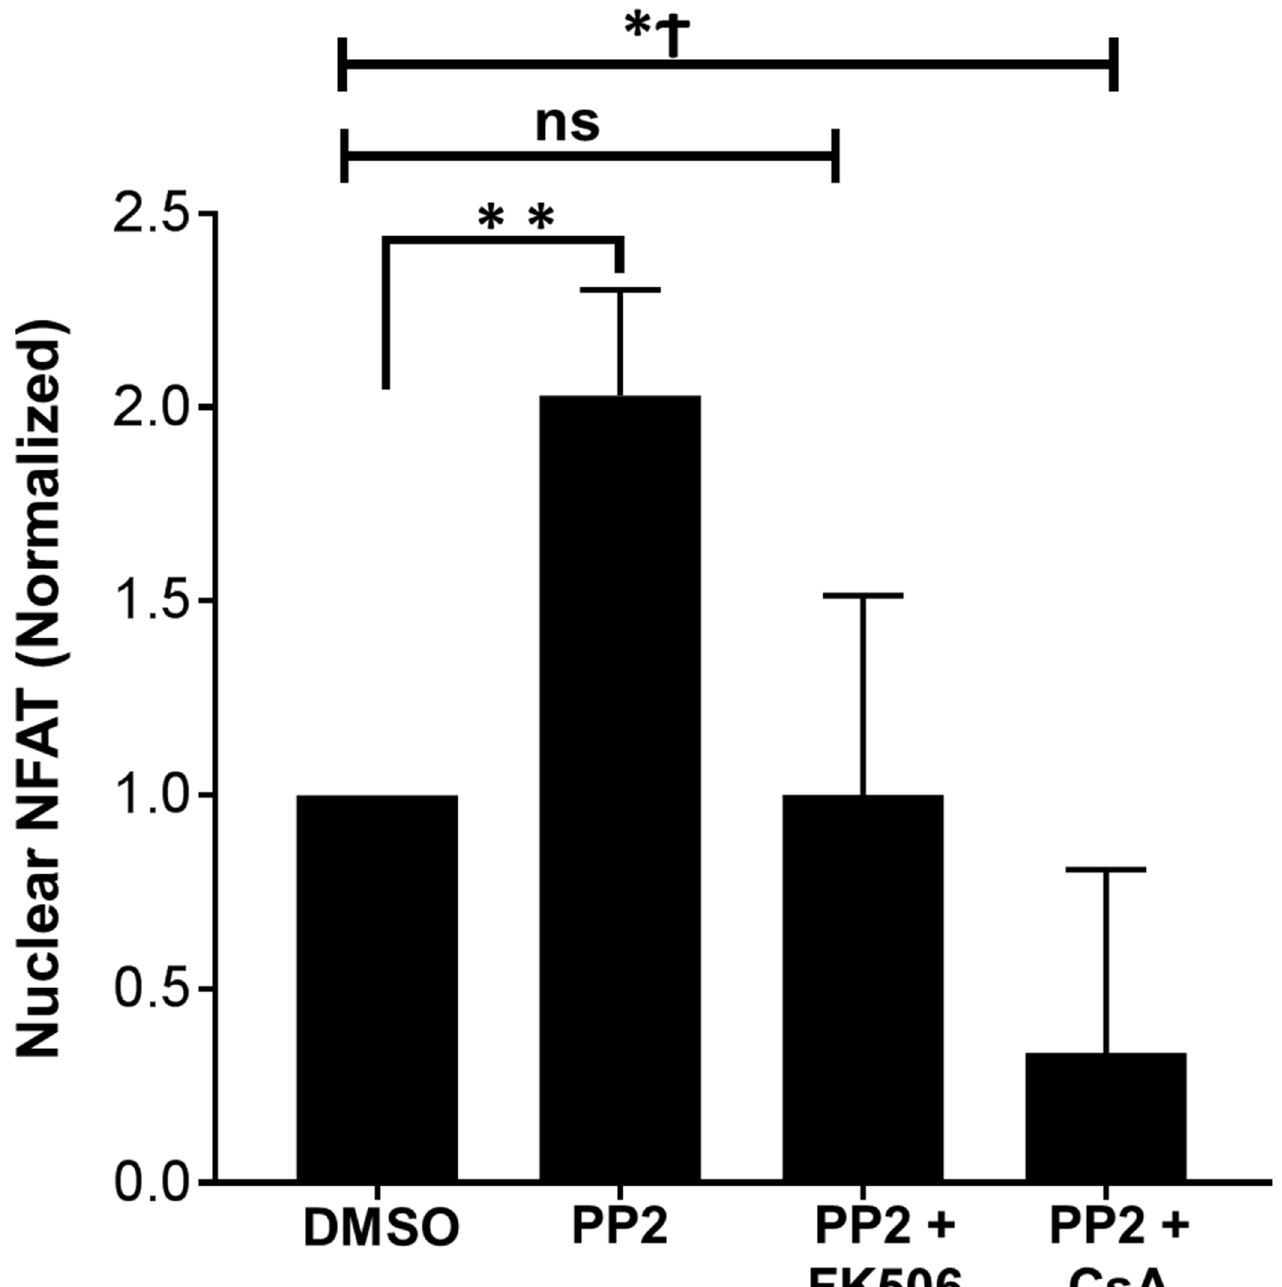
Fig 7. Calcineurin inhibitors prevent aberrantNFAT1 nuclear translocation in resting primary human T cells lacking active SFKs. Primary humanT cells obtainedfrom healthy blood donorswere treated with DMSO alone or PP2 alongwith FK506 or Cyclosporin A (CsA). Following subcellular fractionations, NFAT1 protein in the nuclearfraction was quantifiedand normalizedto the nuclear actin levels. Data represent the averageobtainedfrom three different donors along with the standarddeviation. * P < 0.05, ** P < 0.01, † = averageobtained from two donors.